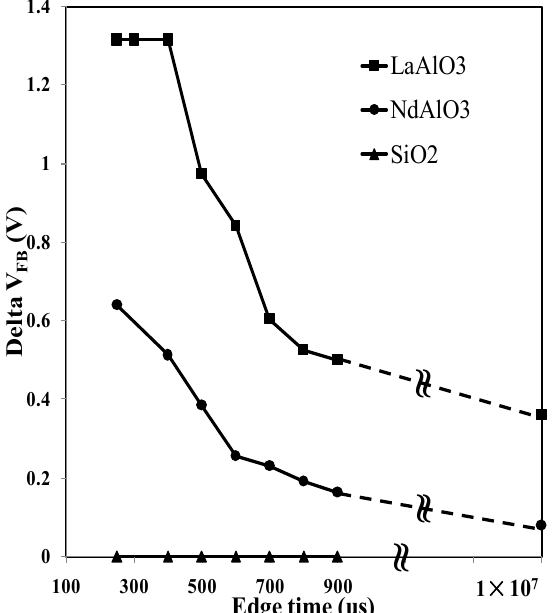
Figure 7. Variation of flat-band voltage (V) with different edging time (μs) of NdAlO 3 , LaAlO 3 and SiO 2